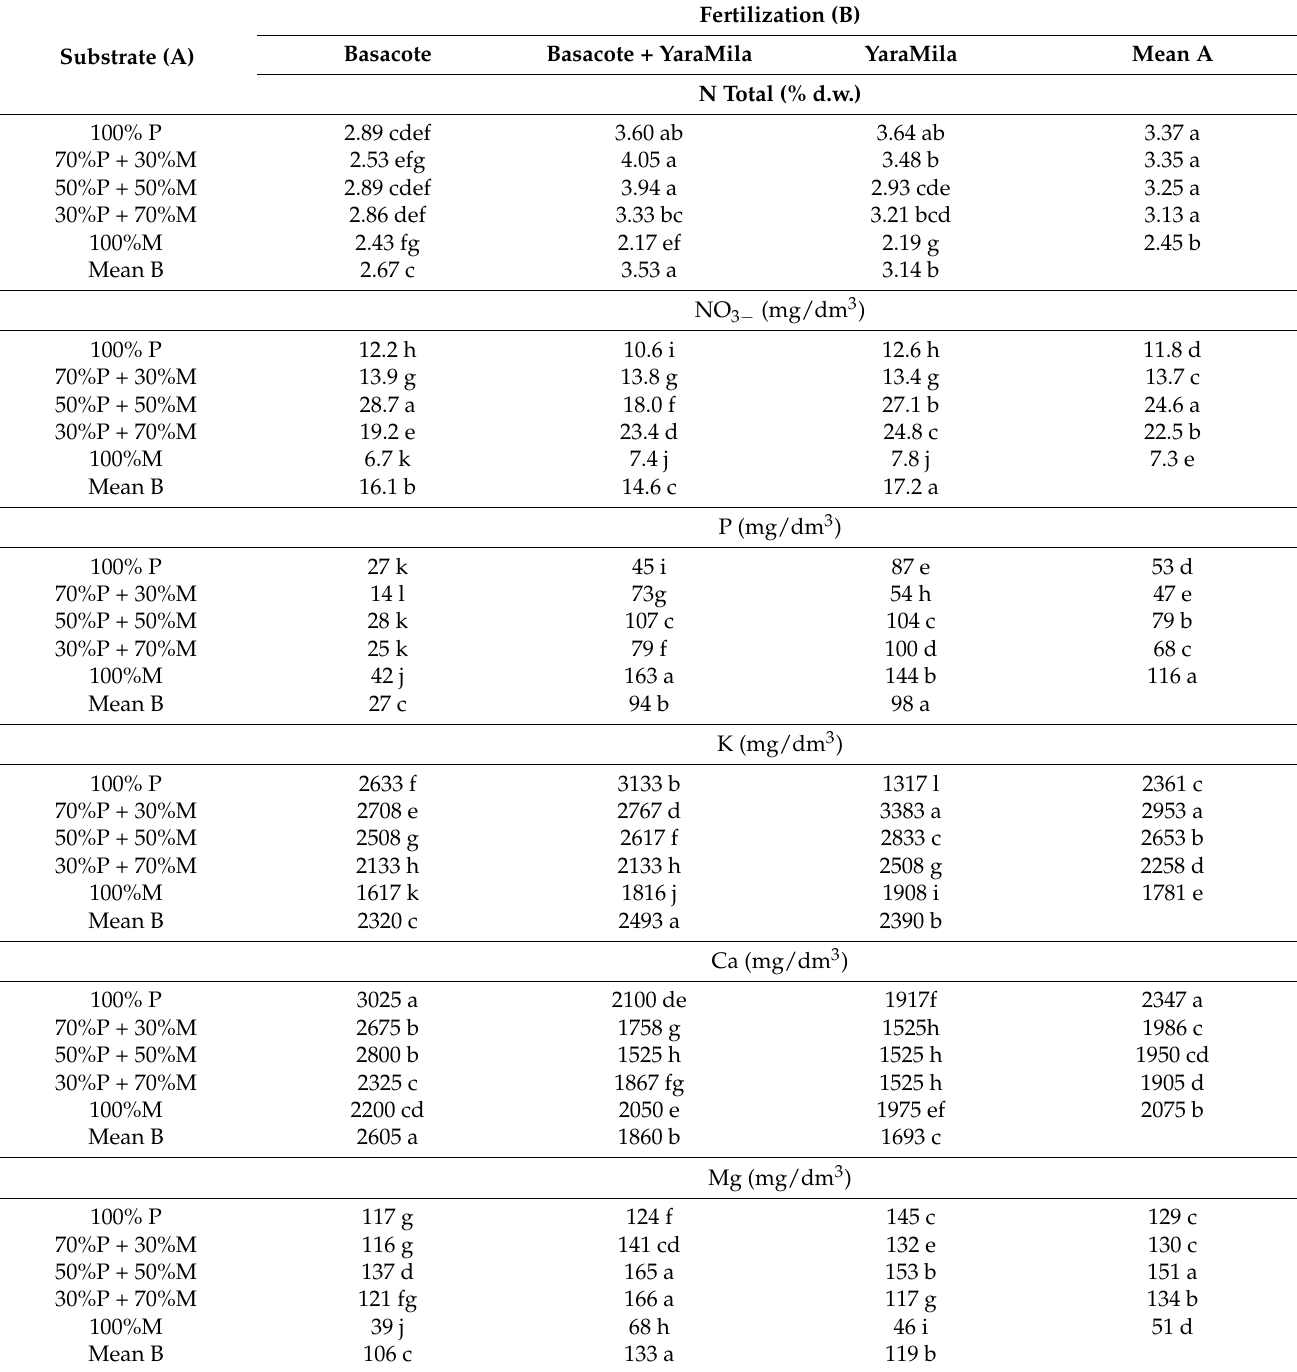
Table 15. Substrate nutrient contents in Hydrangea arborescence ‘Annabelle’ grown in containers with five different